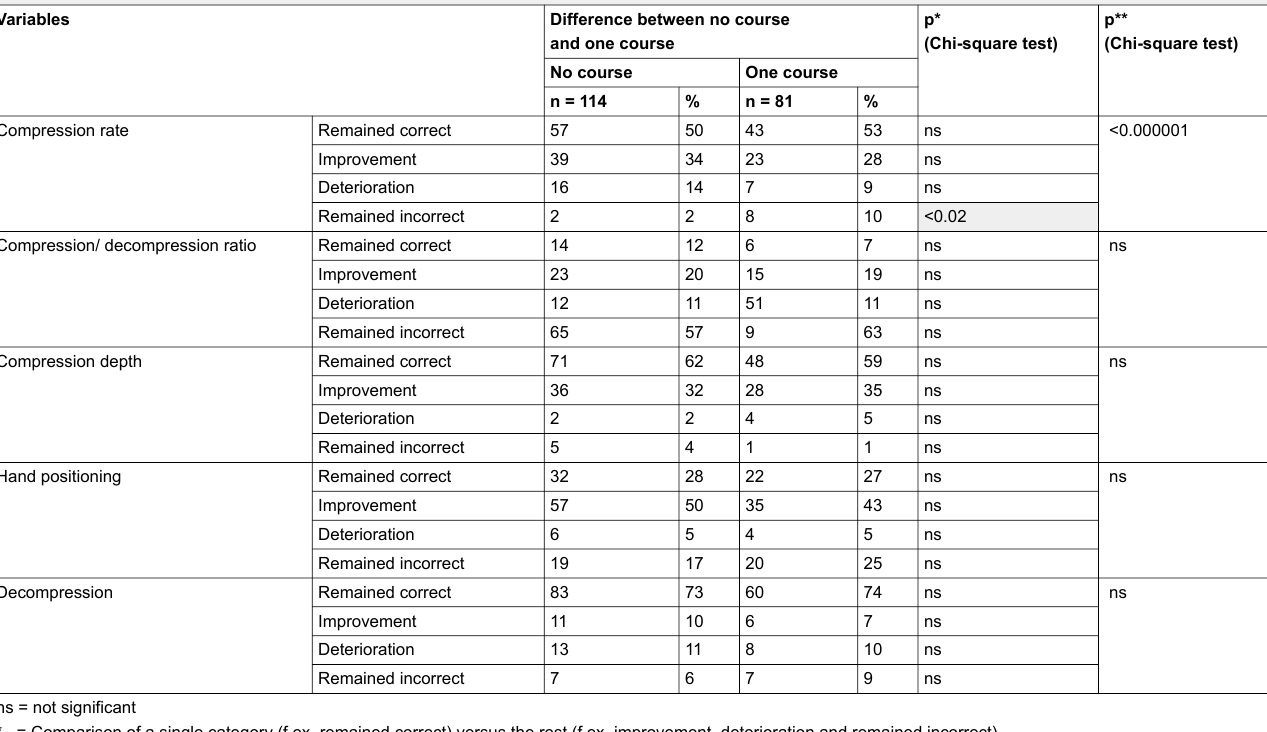
Table 5: Comparison of results after the course between participants with and without a previous course